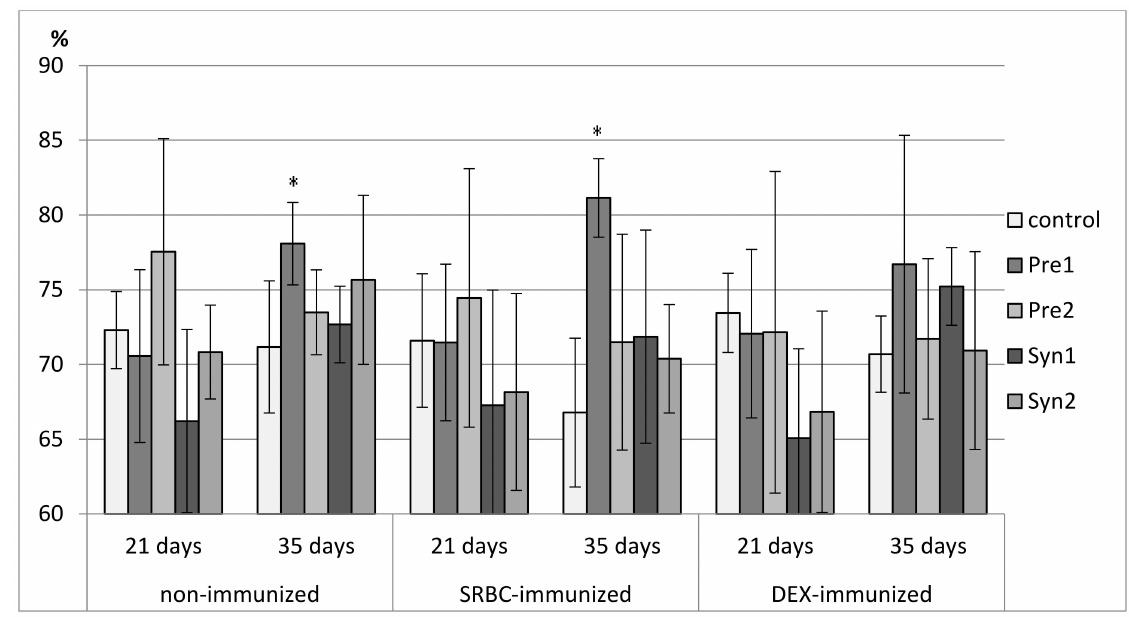
Figure 2. The percentage of CD4 + CD8 + cells in the thymus of chicken broilers after in ovo injection of the investigated prebiotics or synbiotics. The data are expressed as the mean ± SD. Data with a symbol (*) denote a significant difference with respect to the control group ( p < 0.05).